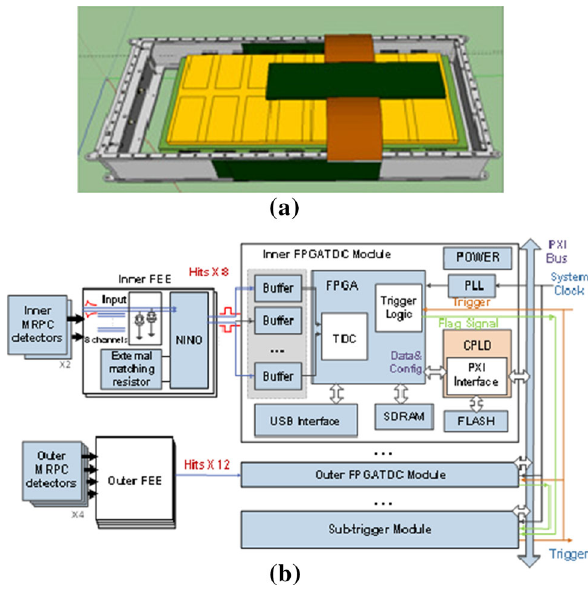
Fig. 5 Block diagram of the readout electronics and CSR T0